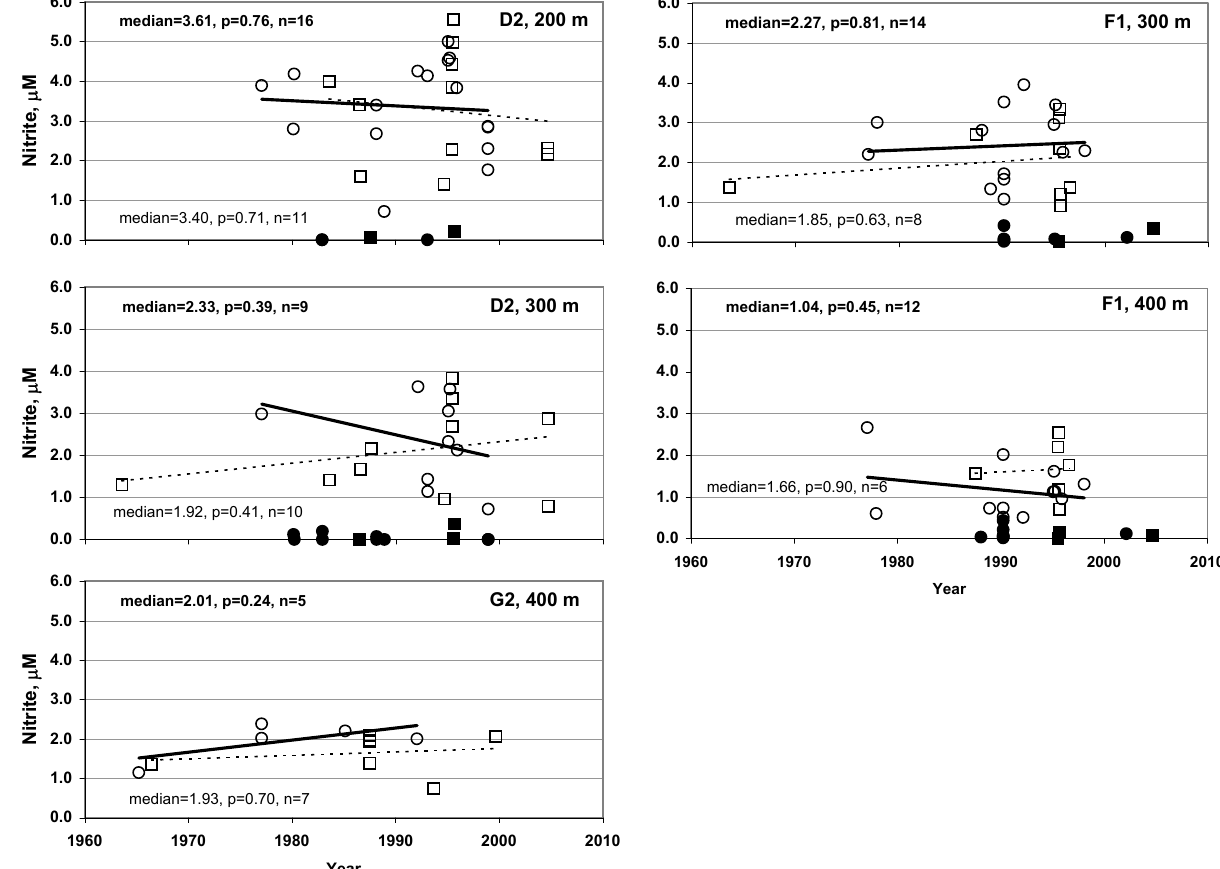
Fig. 5. Examples of regressions of ≥ 0.5µM nitrite on year with data for the NEM (open circles, bold line, and text in upper part of panels) and SWM (open squares, dashed line, and text in lower part of panels) for Boxes D2 (two depths), F1 (two depths), and G2 (one depth), with medians, p for slopes, and number of values (all in Supplement Table S.8, except for D2, 200m, NEM). The < 0.5µM values (filled symbols) are not part of the